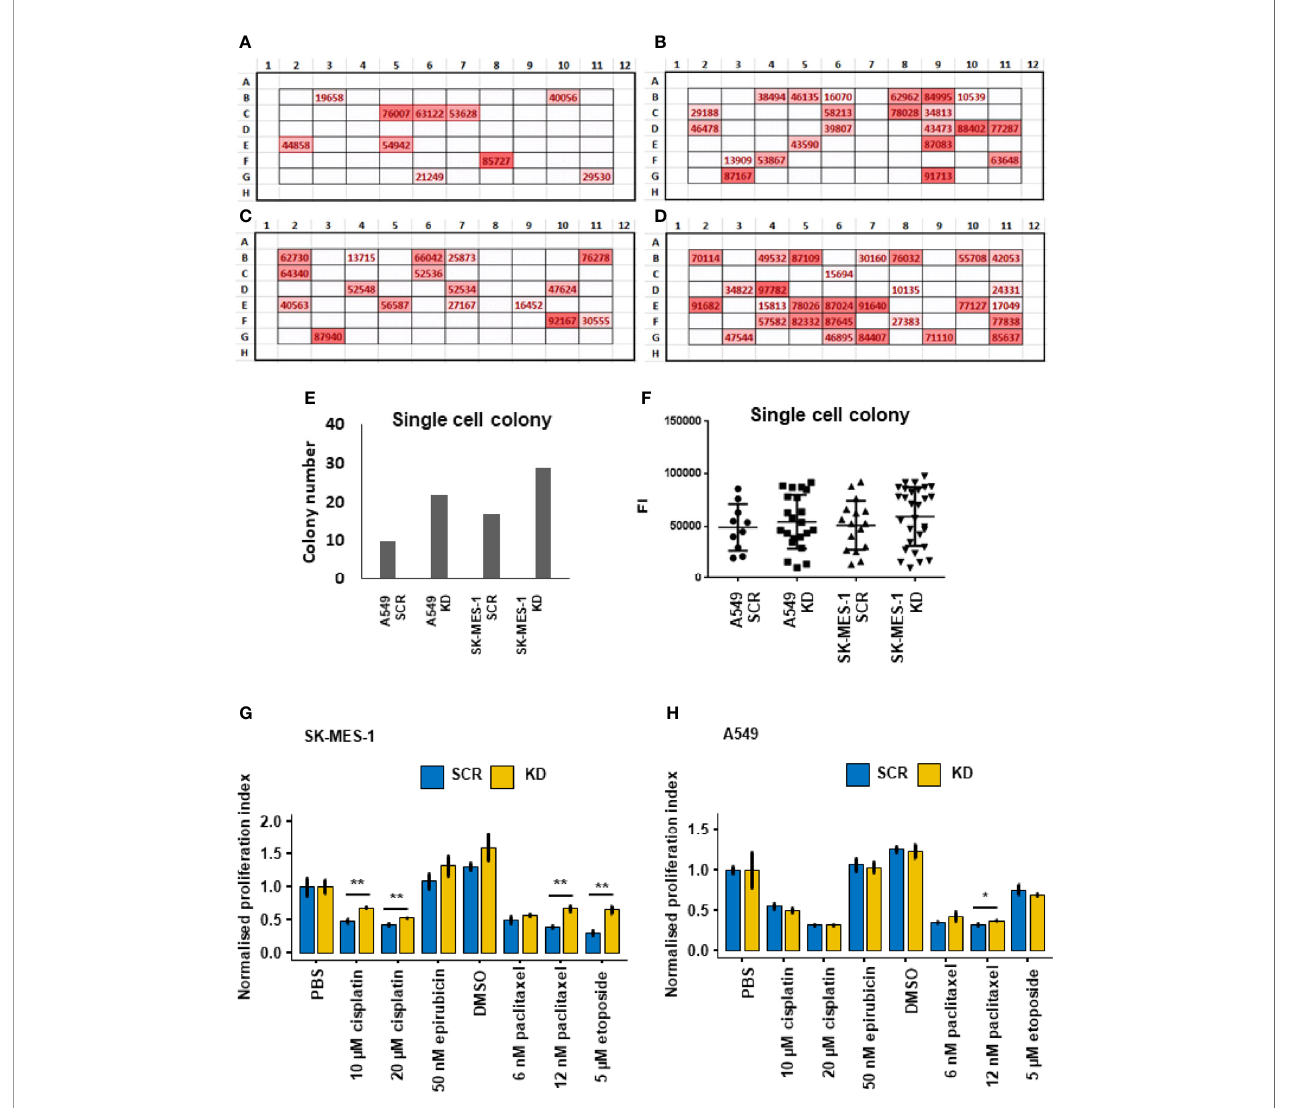
FIGURE 5 | Single-cell colony formation and cellular response to cytotoxic drugs. (A) In situ heatmap of the single-cell colony formation from the A549 SCR cell line in a 96-well plate following cultivation for 3 weeks. The values are fl uorescent intensity (FI) indicated by the Alamar Blue proliferation assay. (B) In situ heatmap of the single-cell colony formation from the A549 KD cell line. (C) In situ heatmap of the single-cell colony formation from the SK-MES-1 SCR cell line. (D) In situ heatmap of the single-cell colony formation from the SK-MES-1 KD cell line. (E) Quanti fi cation of the colony numbers following single-cell culture. (F) Analysis of the FI values of the colonies indicated by Alamar Blue. (G) Cytotoxic response of the stable A549 cell lines to chemotherapeutic drugs indicated by Alamar Blue. The normalised proliferation index is calculated by the division of the FI value of each group with the PBS group. (H) Cytotoxic response of the stable SK-MES-1 cell lines to chemotherapeutic drugs. *p < 0.05, **p <